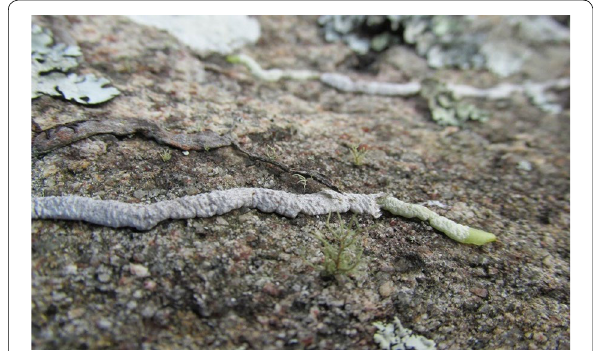
Fig. 3 (Bottom)—Actively-growing root tip of a lithophytic Angrae- cum species. Note the green pigmented tip, and root growth on